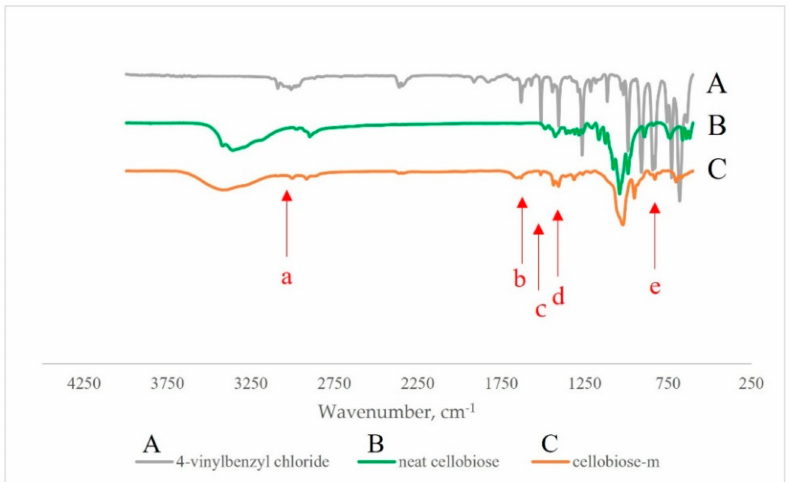
Figure 3. IR spectra of cellobiose before and after the 4-VBC modification: ( A ) 4-VBC; ( B )